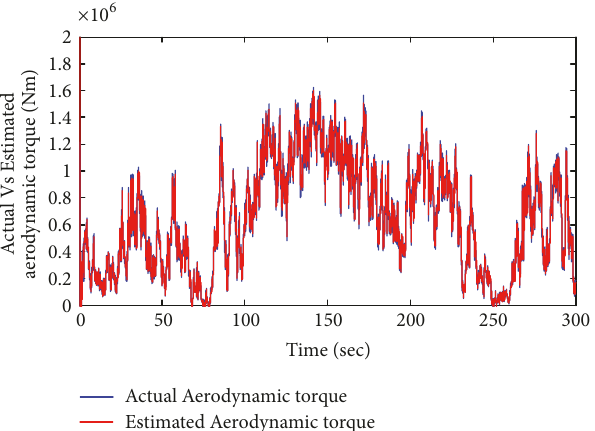
Figure 5: Power spectral density of the actual and estimated shaft torque.